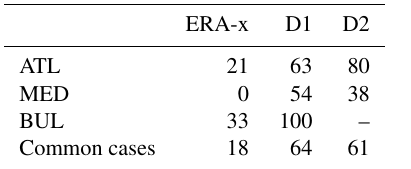
Table 7. Portion of cases (in percent) with (cid:107) WNOE (cid:107) < 20% for each coast (ATL: Atlantic; MED: Mediterranean Sea; BUL: Bul- garian; common cases: cases using D1 and D2